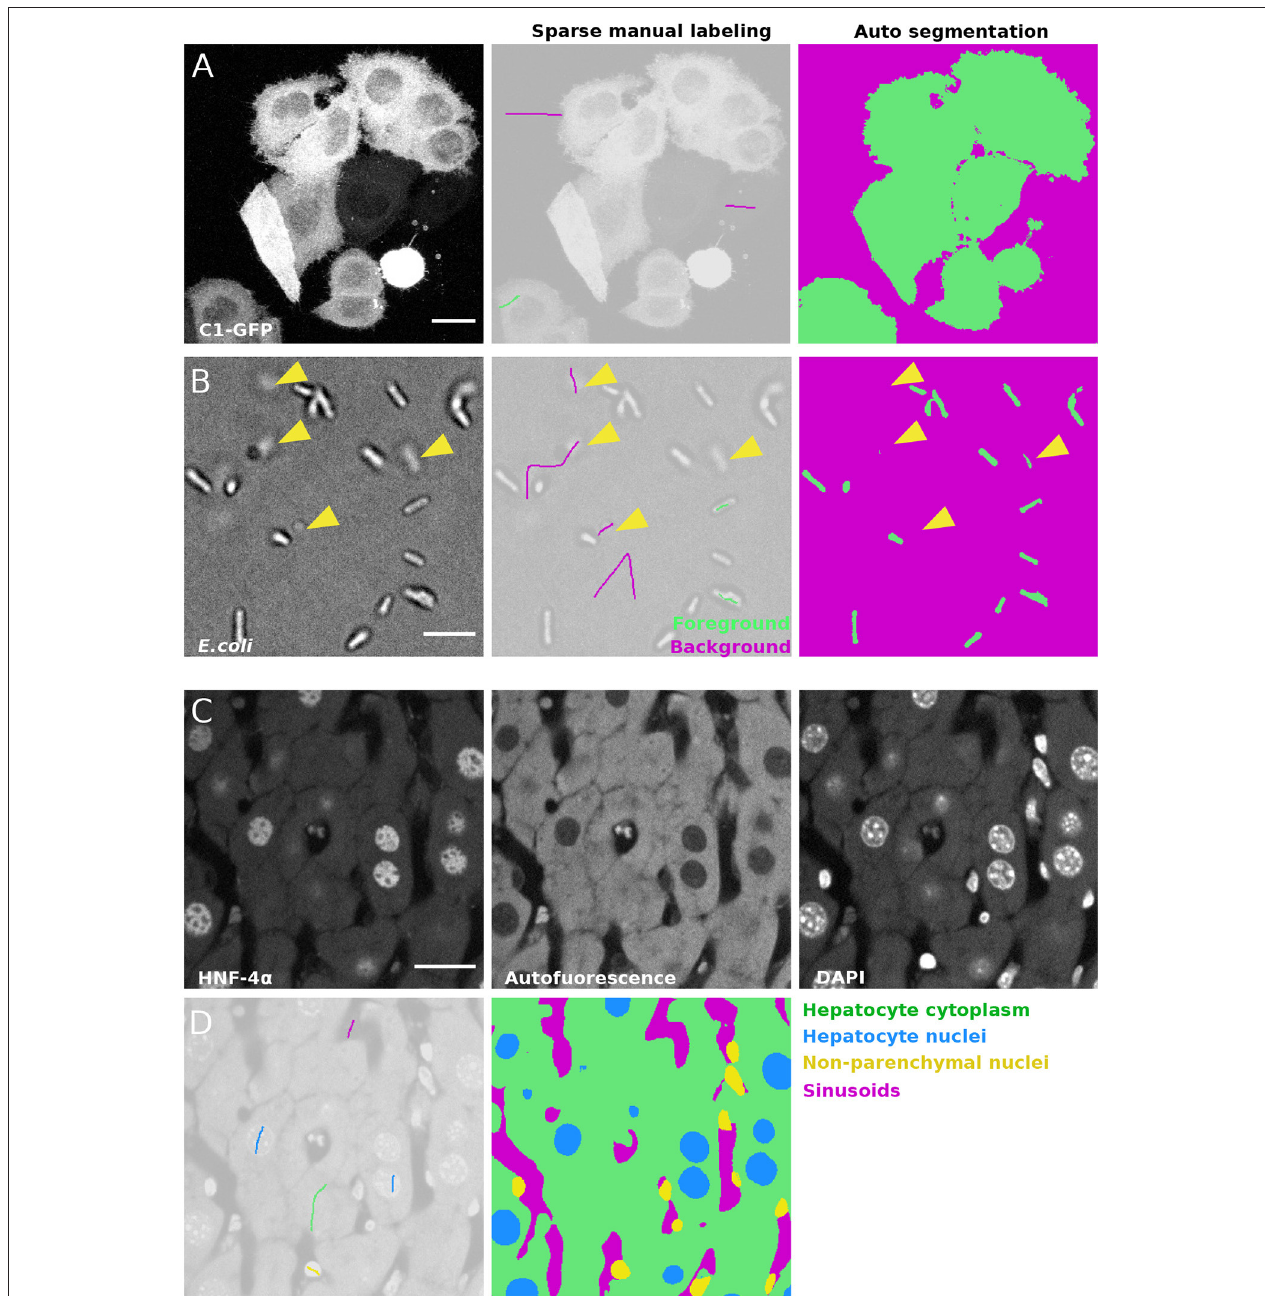
FIGURE 2 | Semantic segmentation of microscopy images with LABKIT ’s pixel classification: (A) Maximum intensity projection of a confocal stack showing HeLa cells expressing C1-GFP (left), next to the sparse labeling (scribbles, center) and resulting cell segmentation (right). (B) Bright field microscopy image of E.coli , sparse labeling discriminating cells and background and the resulting segmentation. Arrowheads show that segmentation of out-of-focus objects can be reduced by including pixels of such objects in the background class. (C) Fixed mouse liver tissue section stained with immunofluorescence and imaged in multiple channels with a spinning disk confocal microscope, showing Hepatocyte nuclei stained with antibody against HNF-4 α a transcription factor expressed in hepatocytes, hepatocyte cytoplasm (autofluorescence) and all nuclei stained with DAPI. (D) Labeling and resulting segmentation of the liver tissue section shown in (A) , segmenting Hepatocyte cytoplasm (green), Hepatocyte nuclei (blue), nuclei of non-parenchymal cells (yellow) and sinusoids (magenta). Scale bars 20 µ m (A) , (C) , and 5 µ m (B) .